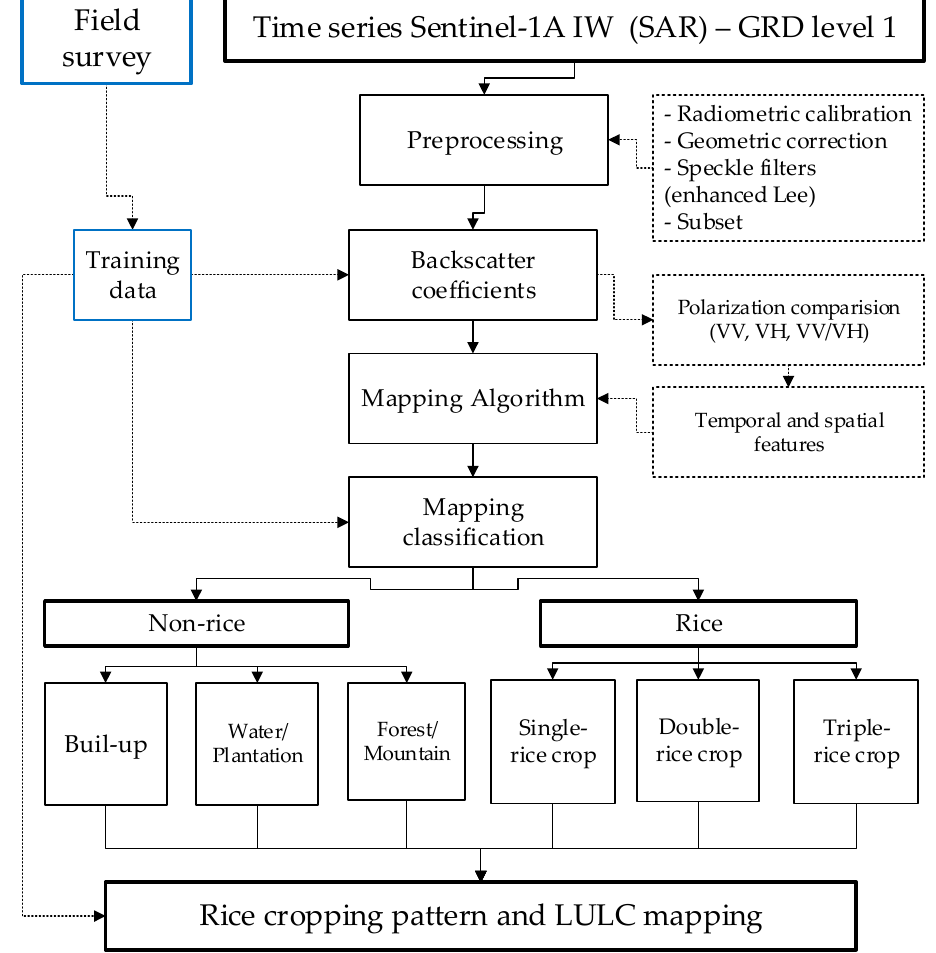
Figure 3. Flowchart of Sentinel-1A processing and rice cropping classification.